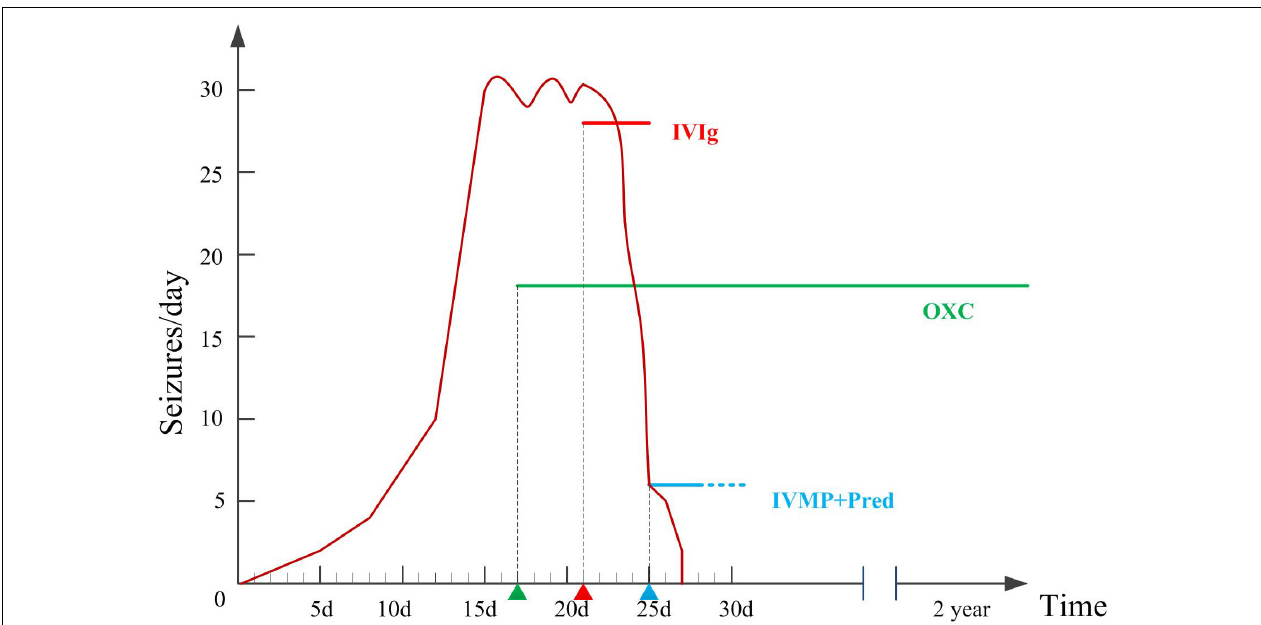
FIGURE 2 | Therapeutic interventions and number of seizures per day during hospitalizations and two years